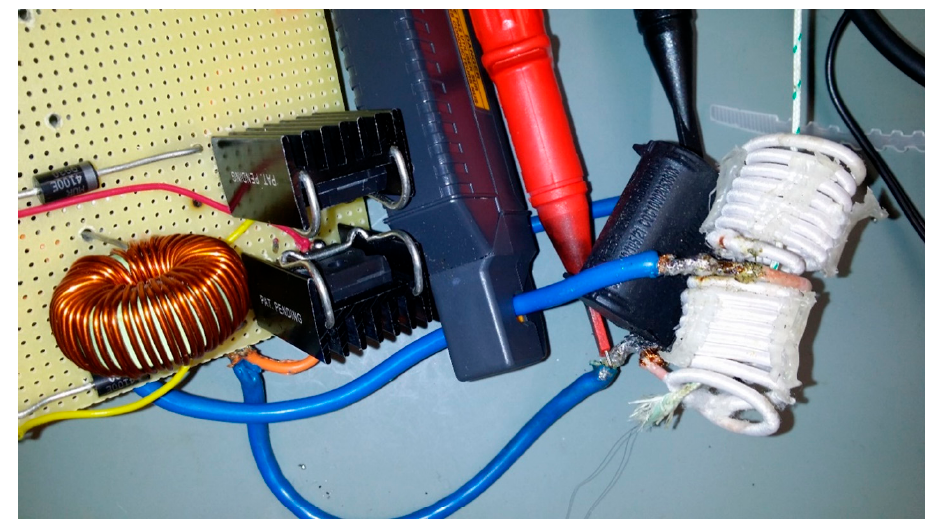
Figure 5. Work coil for power transfer to IOFEF joints.